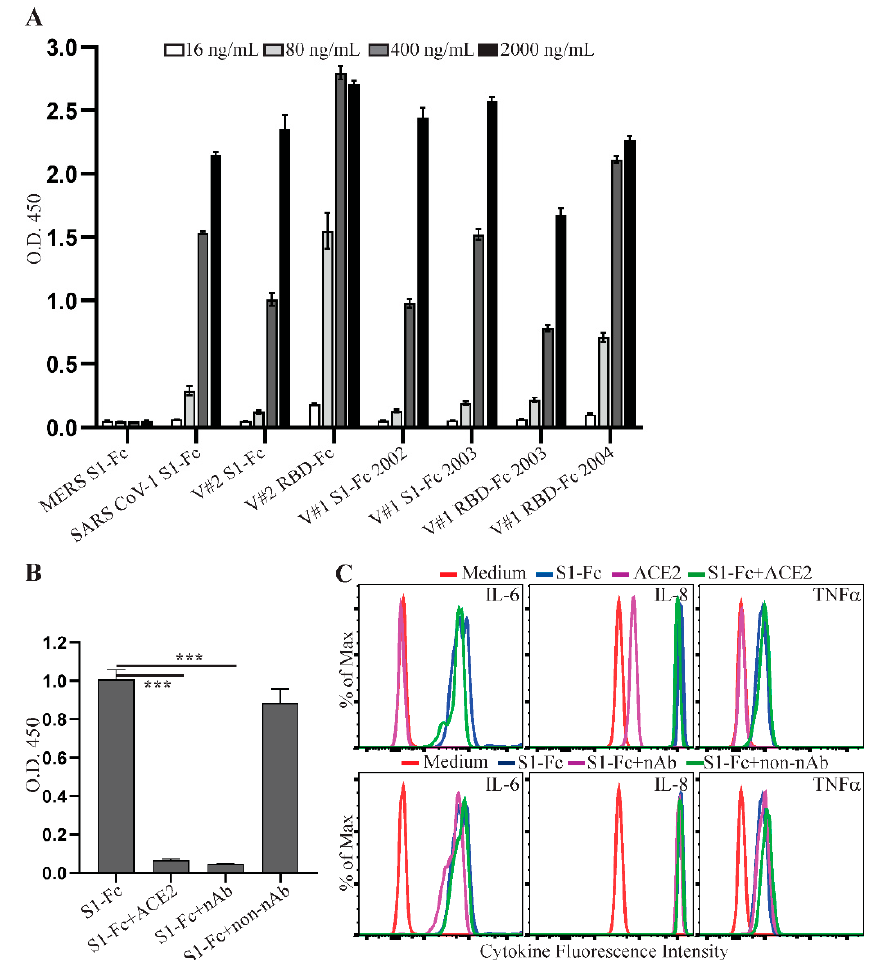
Figure 4. SARS CoV-2 spike protein-induced cytokine production is independent of its binding to ACE2. ( A ) The binding activities of coronaviral spike Fc fusion proteins to ACE2 were measured using an ELISA. The binding activities of 16, 80, 400 and 2000 ng/mL of the indicated proteins were presented as absorbance at 450 nm (O.D. 450). ( B ) Inhibition of S1-Fc binding to ACE2 by soluble ACE2 or a neutralizing anti-S1 antibody; 400 ng/mL of S1-Fc were preincubated with or without 2 µg/mL of soluble ACE2, 1 µg/mL of neutralizing (nAb) or non-neutralizing (non-nAb) anti-S1 antibody before incubation with plate-bound ACE2. Statistical analyses were performed using a two-tailed, Student’s t -test. *** depicts p < 0.001. ( C ) Rested PBMC were cultured with or without 2.0 µg/mL of S1-Fc in the presence or absence of 5 µg/mL of soluble ACE2, 2 µg/mL of nAb or non-nAb for 24 h. The levels of IL-6, IL-8 and TNF α in the supernatants of cultured PBMC were assessed using the CBA human inflammatory cytokine kit and flow cytometric analysis.